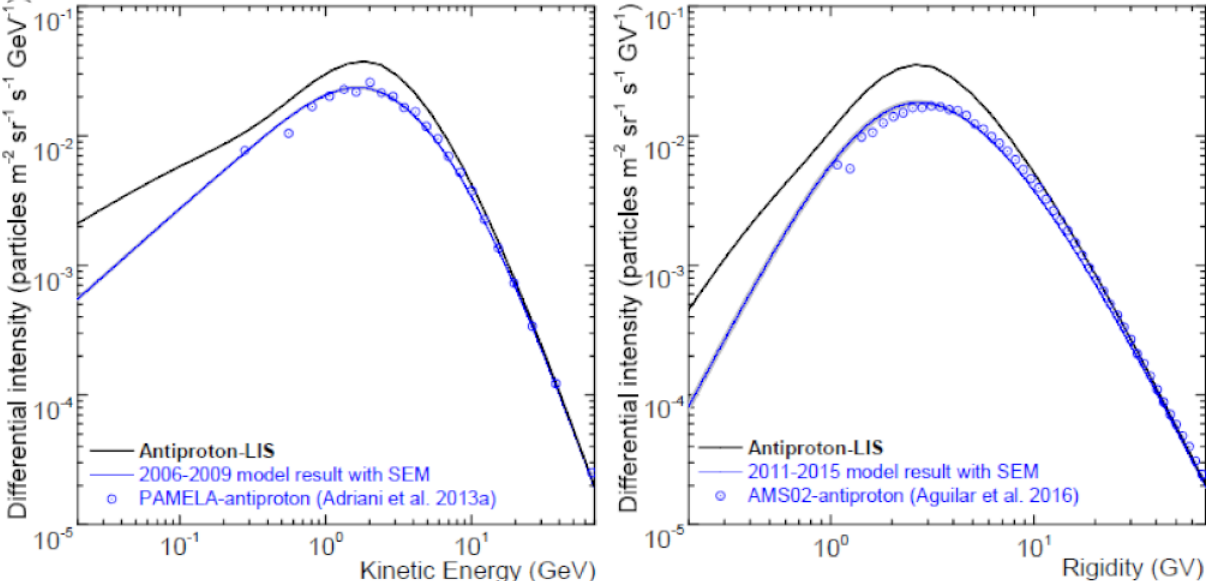
Figure 17. Modulated anti-proton spectra as computed with this work modulation model compared here with long-time averaged observations from PAMELA (July 2006–December 2009) [152] in the right-side panel and AMS-02 (May 2011–May 2015) [4] in the left-side panel as. The VLIS in each panel is shown as solid black lines and the computed, modulated spectra, averaged over corresponding periods, are shown by solid blue lines. SEM indicates standard error of mean (standard √ deviation/